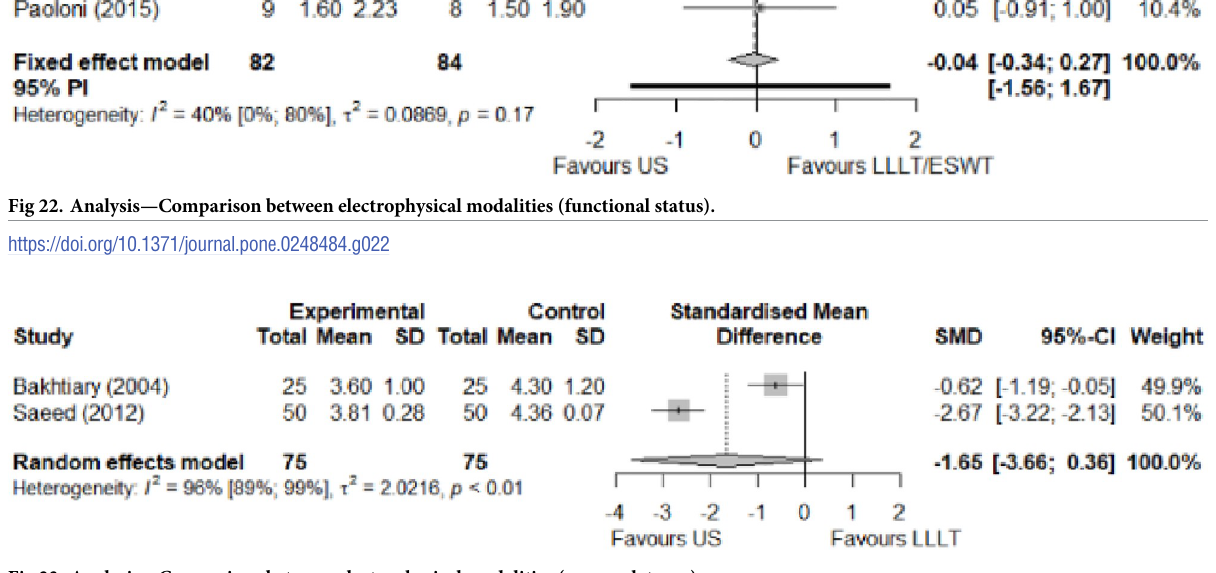
Fig 23. Analysis—Comparison between electrophysical modalities (sensory latency).